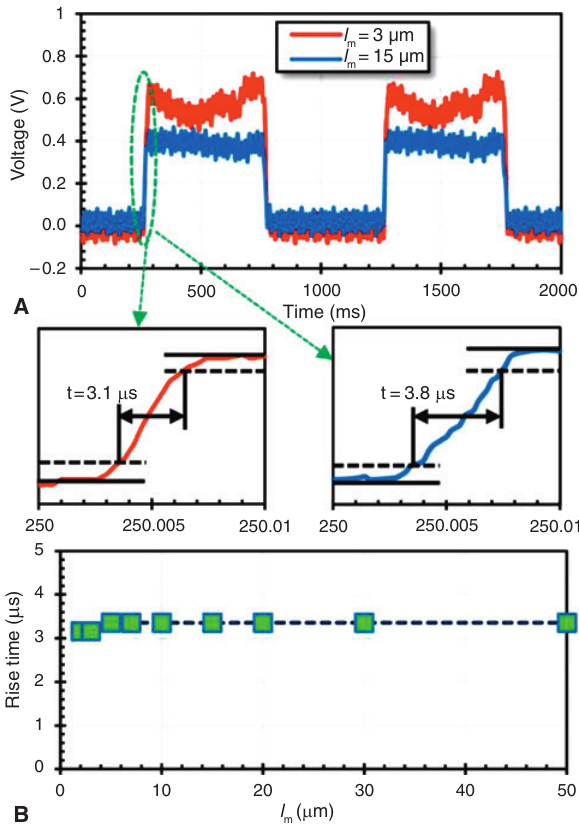
Figure 6: Temporal responses. (A) Measured electrical temporal responses for an input optical Figure 7: Wavelength dependence. = 2 V. The signal with a modulation frequency of 1 kHz when V (A) Wavelength dependence of the responsivity of the fabricated bias = 3 and 15 μ m, respectively. Insets: rising length is chosen as l optical power monitor with l m edges. (B) Calculated electrical temporal rise time of the power Wavelength dependence of the metal absorption in a 5- and 10- μ m- = 400 nm. monitor with different lengths l . Here, w long metal strip. Here, w m m